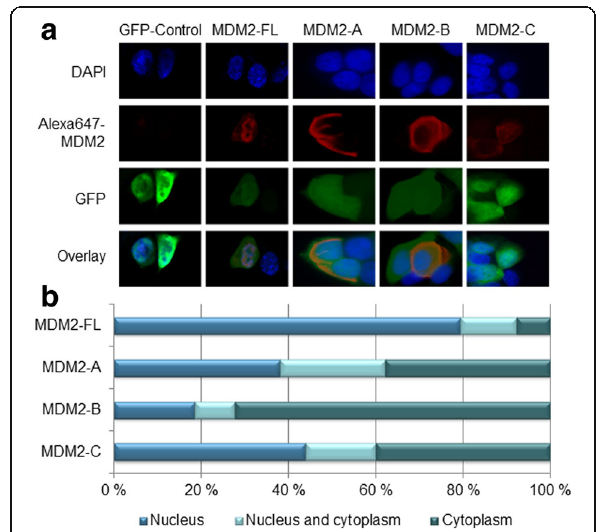
Fig. 2 Sub-cellular localization of the MDM2-splice variants. ( a ) MCF-7 cells transfected with pCMV-GFP (GFP-control), MDM2-FL, -A, -B and -C evaluated by indirect immunofluorescence for determination of cellular localization of the proteins. Top lane shows the nucleus by Hoechst staining ( blue ), second lane shows the cells expressing GFP ( green ), third lane shows the AlexaFlour 647 MDM2 antibody ( Life Technologies, red ), and lastly, an overlay of the tree previous pictures. ( b ) Percentage of cells with exclusively nuclear ( dark blue bars ), nuclear and cytoplasmic ( blue bars ) or exclusively cytoplasmic ( light blue bars ) localization of the MDM2-A, -B and -C. For each of the differently transfected cell samples the sub cellular localization was determined for 50 transfected cells with each of the constructs. The experiment was repeated in triplicate, with three independent transfections. Cells were counted by three